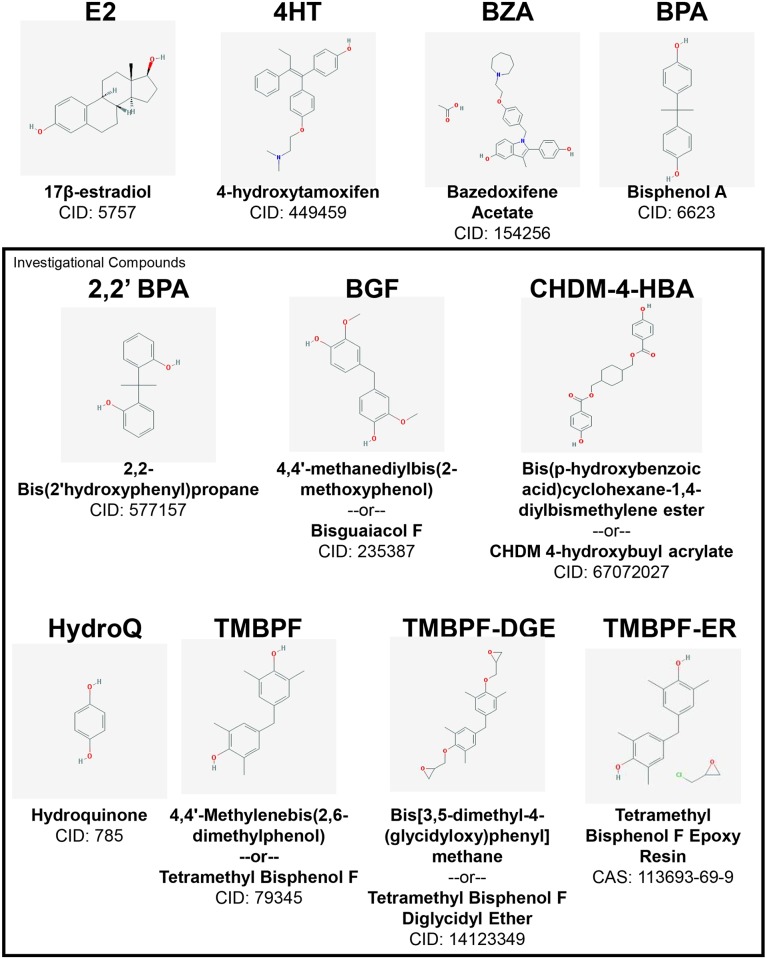
Chemical structures and identification numbers for compounds analyzed.Each compound is identified by an abbreviation, full name, and a PubChem compound identification (or CAS) number.